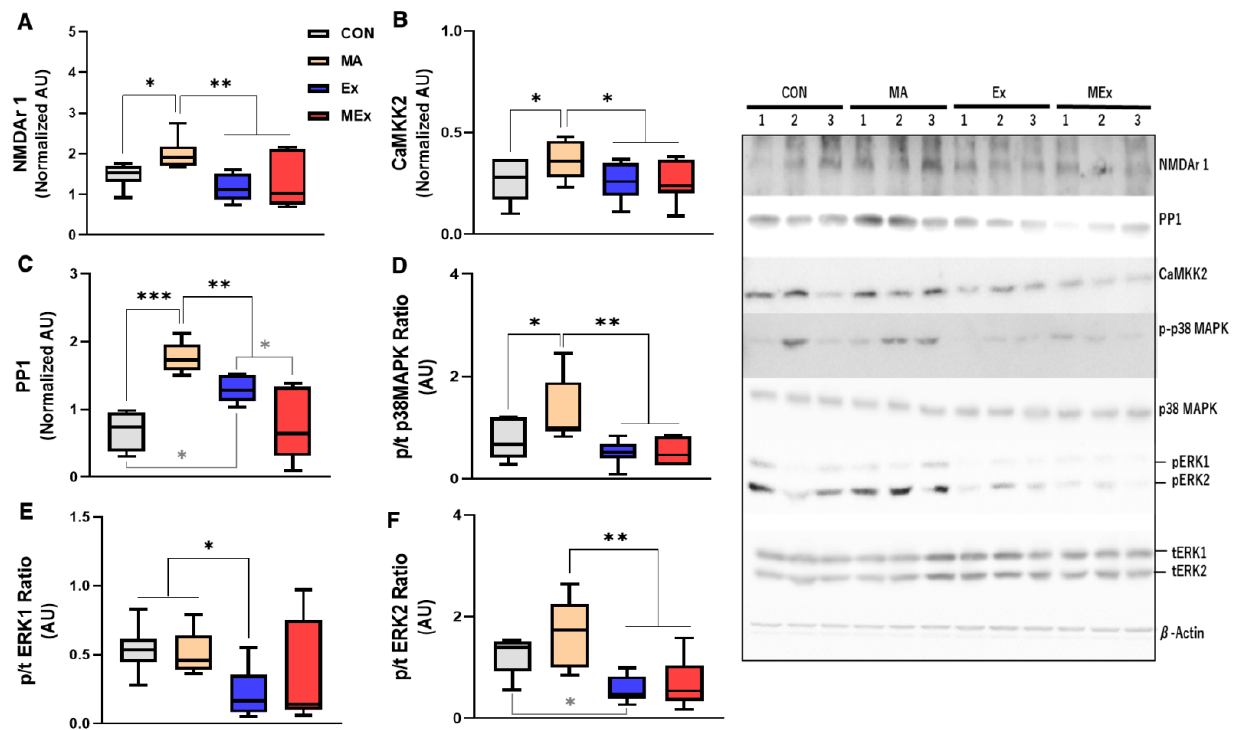
Figure 4. Forced endurance exercise training significantly reduced the methamphetamine (METH)-induced striatal glutamatergic signaling pathway. Protein content was determined by Western blotting in the striatum of brains of experimental rats. ( A ) NMDA receptor 1 (NMDAr1) expression level ( n = 8 per group, F (3, 27) = 6.718). ( B ) CaMKK2 expression level ( n = 8 per group, F (3, 26) = 2.489). ( C ) PP1 expression level ( n = 8 per group, F (3, 27) = 19.68). ( D ) p/t-p38MAPK ratio ( n = 7 per group, F (3, 24) = 7.042). ( E ) p/t ERK1 ratio ( n = 7 per group, F (3, 21) = 2.118). ( F ) p/t ERK2 ratio ( n = 7 per group, F (3, 23) =